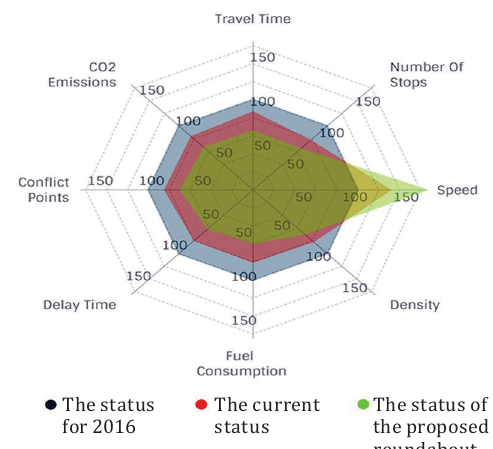
The status for 2016